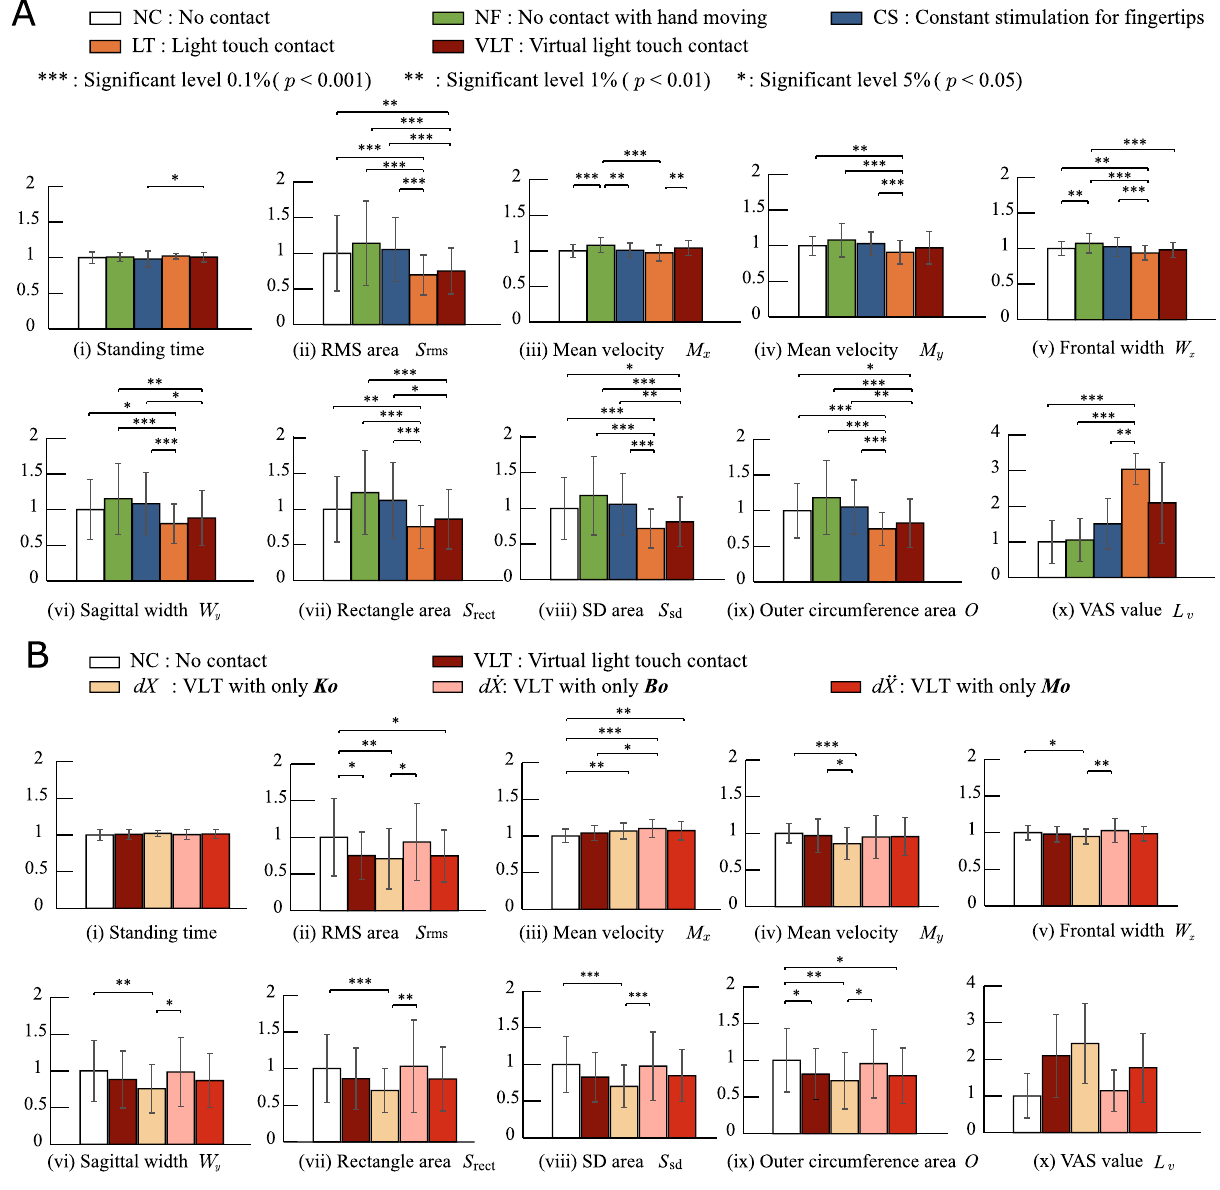
Figure 5. Experimental results for six subjects for each evaluation index (experiments 1 and 2). ( A ) Mitigation effect of virtual light touch in a tandem stance (experiment 1) ( B ) Examination of relationships between non- contact impedance parameters and human standing (experiment